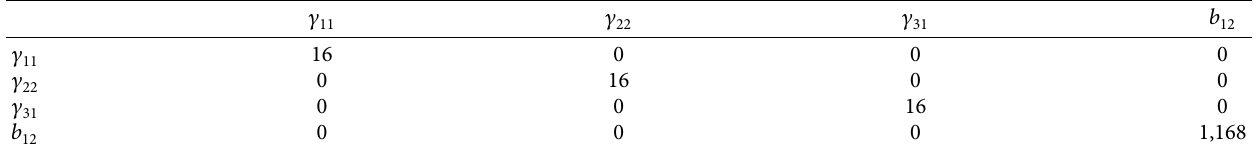
Table 9: Asymptotic information matrix for Example 2 based on the orthogonal design.